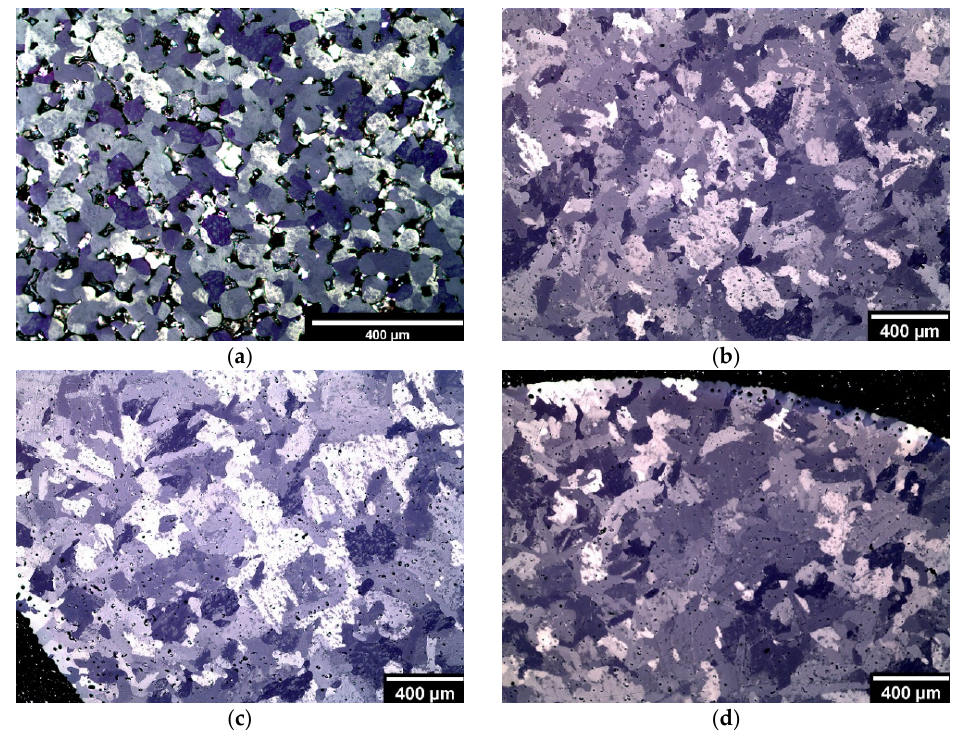
Figure 10. Optical micrographs of the polished samples for: ( a ) sample sintered using the current study feedstock; ( b – d ) centre and edges of a sample sintered using commercial feedstock.